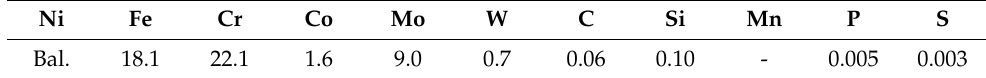
Table 2. Chemical composition of Hastelloy X powder, wt%.